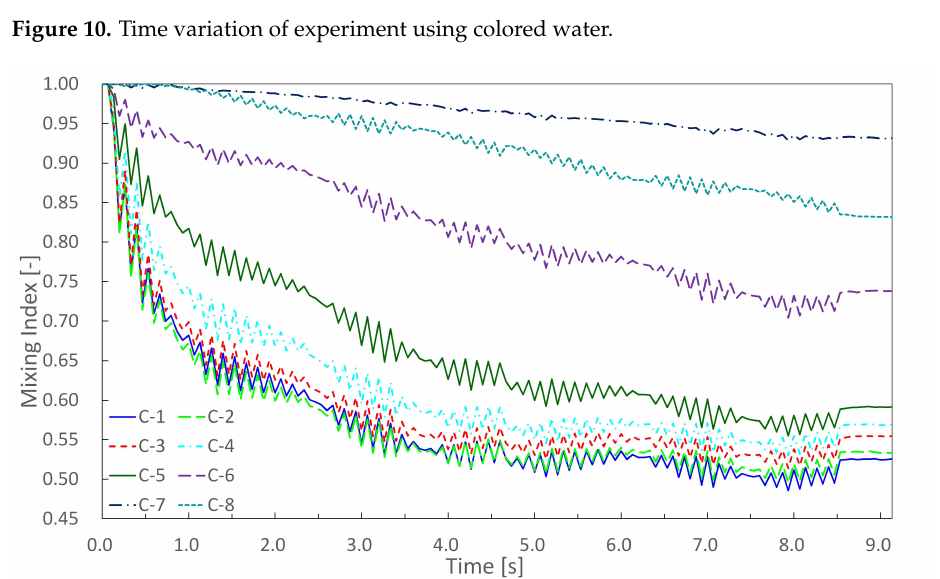
Figure 11. Time variation of mixing index in experiments using colored water. We obtained s similar result as that in experiments using 3 µ m microbeads. Final mixing indices were C-1, -2, -3, -4, -5, -6, -8,